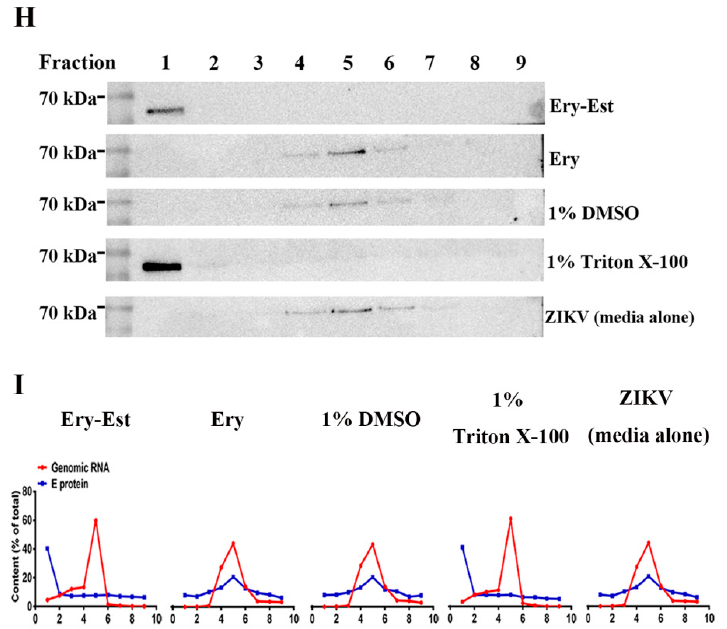
Figure 3. Early stages of ZIKV infection were inhibited by Ery-Est. ( A ) BHK21 cells (2 × 10 6 ) were infected with ZIKV SZ01 and Ery-Est was added at di ff erent time points post infection. Plaque assay was used to detect viral infection. ( B ) The experimental scheme of viral lifecycle. In the entry experiment, cells were infected with ZIKV SZ01 in the presence of Ery-Est, Azi, Ery, or DMSO at 37 ◦ C for 1 h, and then the unbound viruses and drugs were washed and removed. In the attachment experiment, virus infected cells were presented with Ery-Est, Azi, Ery, or DMSO at 4 ◦ C for 1 h, allowing viral attachment but not membrane fusion due to the low temperature, and washed to remove the unbound viruses and drugs. In the fusion assay, cells were first infected with virus at 4 ◦ C for 1 h for viral attachment and washed to remove the unbound viruses, then incubated in the presence of Ery-Est, Azi, Ery, or DMSO at 37 ◦ C for 1 h to allow virus fusion, and unbound drugs were finally removed. In the post-entry experiment, cells were first infected with virus at 37 ◦ C for 1 h to allow virus entry into cells and washed to remove unbound viruses, then Ery-Est, Azi, Ery, or DMSO was added to infected cells for 12 h. Viral infection of those four experiments were evaluated by plaque assay. ( C ) ZIKV, ( D ) DENV II, and ( E ) YFV 17D were respectively treated by Ery-Est at 37 ◦ C for 2 h, after being separated from Ery-Est by PEG-8000, and the viruses were measured for their infectivity. Degradation of released genomic RNA of ZIKV treated by ( F ) Ery-Est or ( G ) Ery in an RNase digestion assay. The genomic RNA coding E protein was detected. The separation of E protein and of ZIKV treated by Ery-Est, Ery, 1% DMSO, and Triton X-100 or with media alone through a sucrose density gradient assay. E protein in each fraction was assessed by ( H ) Western blot and each percent was analyzed by Image J software and then calculated. ( I ) Genomic RNA in each fraction was separated and each percent of total RNA genome was measured by RT-qPCR. For ( A ) to ( G ), the experiments were tested in triplicate and data are represented as means ± SD. Each experiment was repeated at least twice and similar results were obtained. Statistical analysis: unpaired Student’s t test for ( B ); two-way ANOVA with Sidak’s multiple comparisons for ( C – E ); one-way ANOVA with Dunnett’s multiple comparisons for ( F ) and ( G ). ns = not significant. * p < 0.05; ** p < 0.01; *** p < 0.001. **** p <